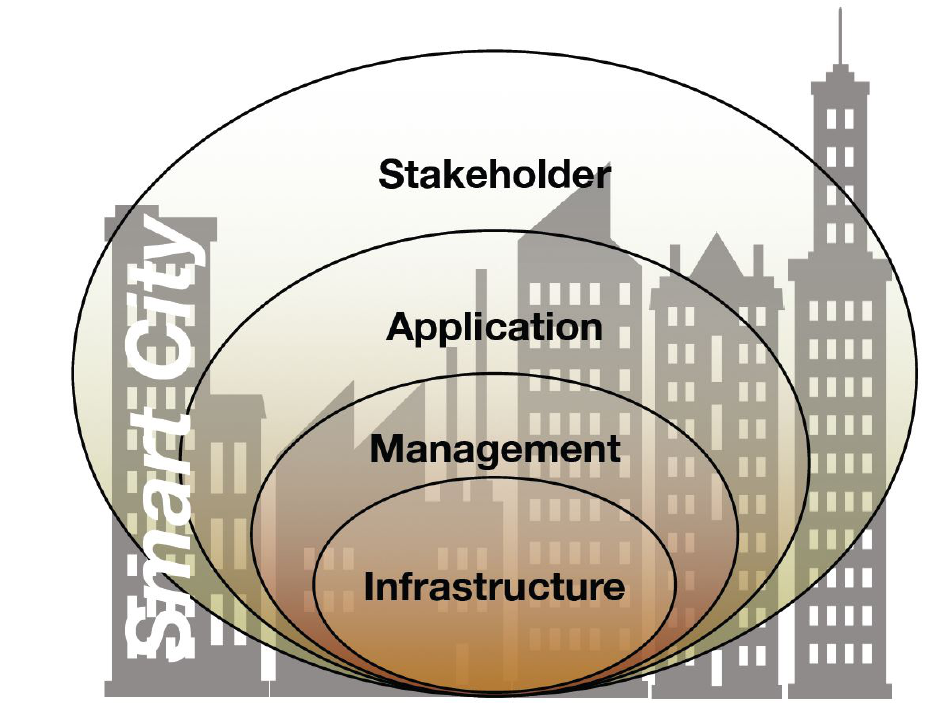
Figure 2. The four-layer model of a smart